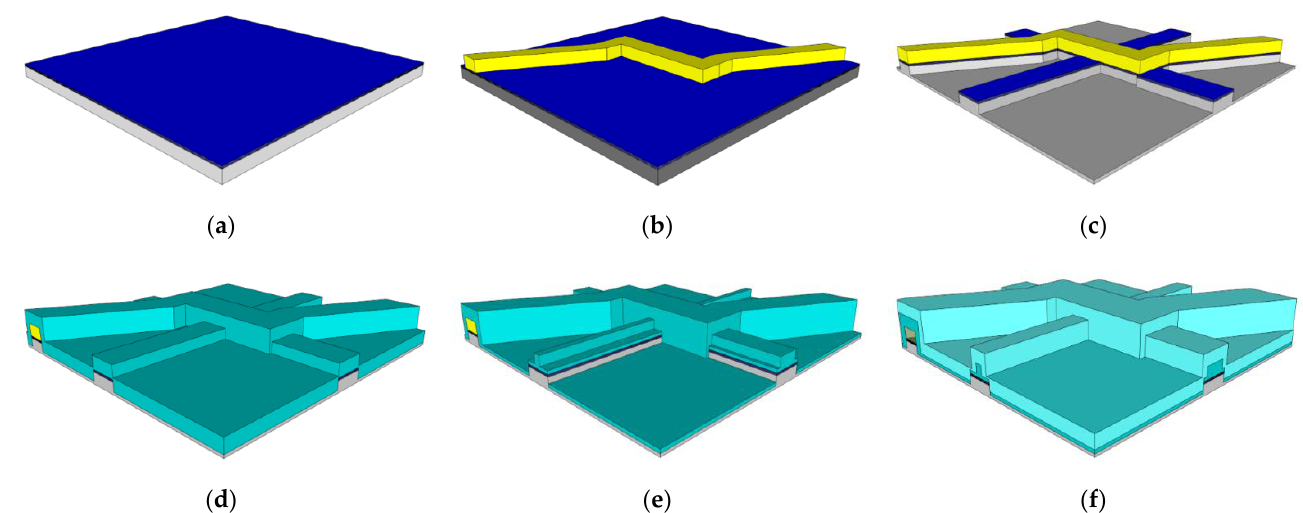
Figure 3. ( a ) ARROW layers are grown on top of a silicon substrate. ( b ) SU8 photoresist is coated on the ARROW layers, is patterned and developed by photolithography to leave the sacrificial core for the ARROW channel. ( c ) A pedestal for the core and pending solid waveguides is etched into the silicon bulk. ( d ) A layer of 1.51 refractive index silicon dioxide is grown over the whole device. ( e ) Ridges are etched into the oxide layer to make the excitation and collection waveguides. ( f ) A second silicon dioxide layer, 1.46 refractive index, is grown over the whole device, and the sacrificial core is etched out to leave the ARROW channel clear for fluid flow.